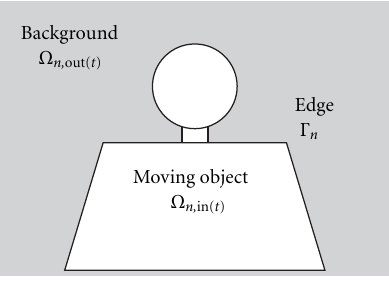
Figure 1: Domains